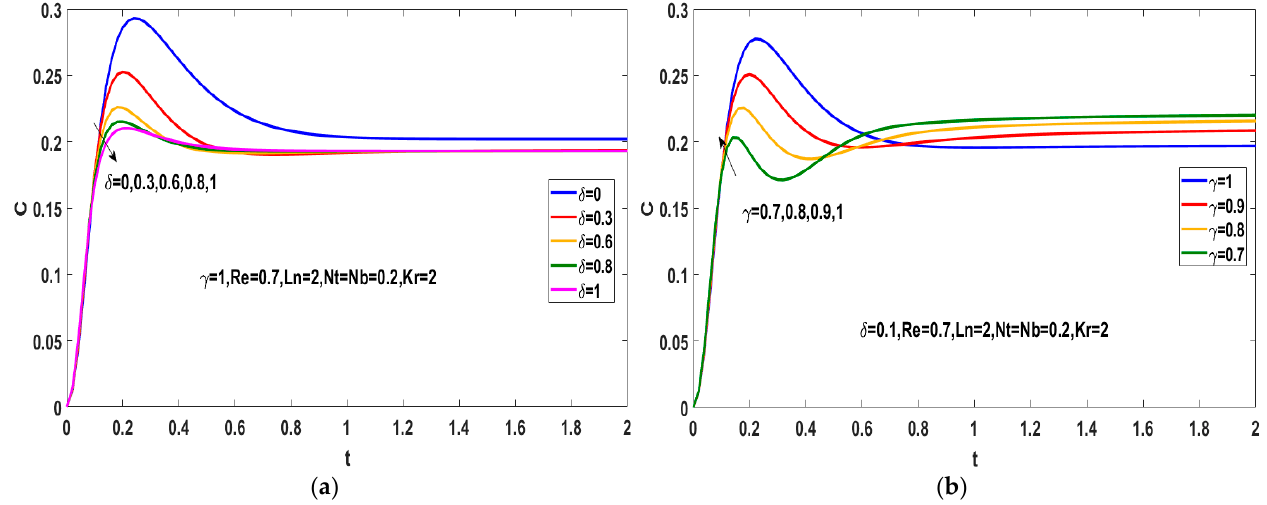
γ . Figure 6. Concentration distributions with respect to t : ( a ) for different δ ; ( b ) for different γ